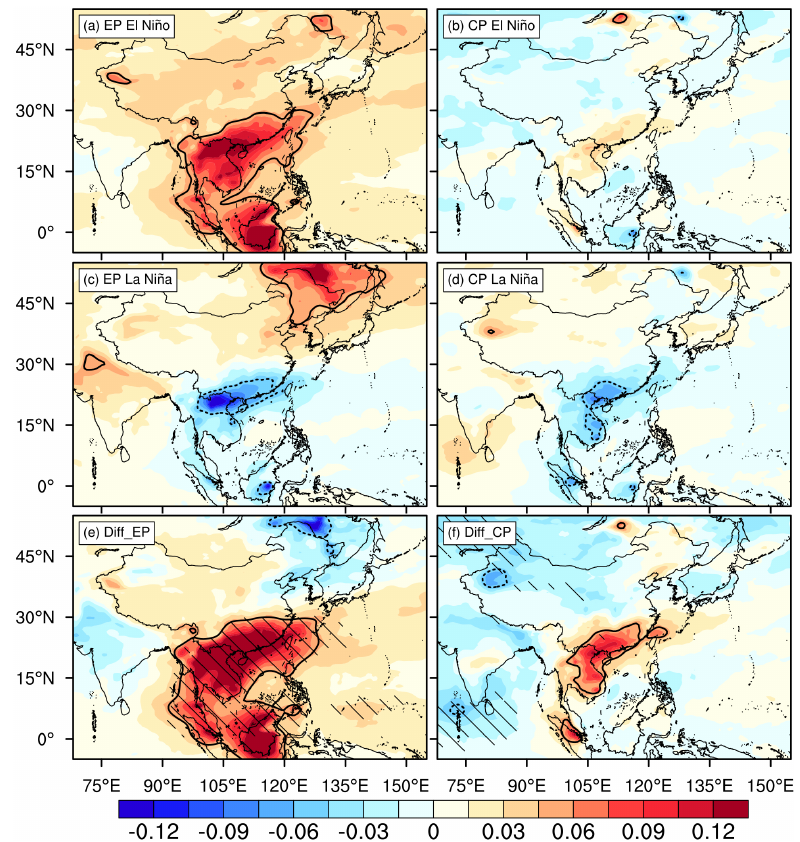
Figure 9. Same as Fig. 4, except for (a, c, e) EP and (b, d, f) CP ENSO